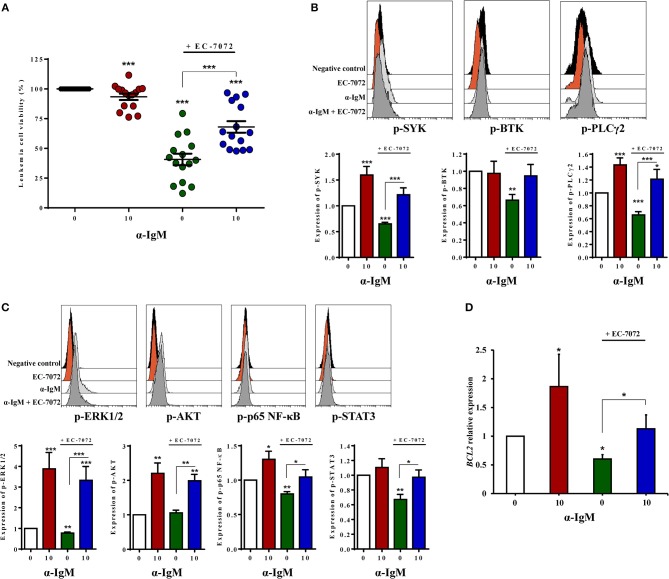
Activation of the BCR partially abrogates EC-7072-induced cell death of primary CLL cells. (A) Leukemia cell viability was determined by cytofluorometric assessment of DiOC6(3)/PI staining in PBMCs from patients with CLL (n = 15) incubated with EC-7072 (200 nM) in combination with α-IgM (10 μg/mL) for 24 h. The graph depicts the percentage of viable [DiOC6(3)+] cells normalized to their respective control (DMSO) condition for each individual patient and dark lines represent mean ± SEM. (B) Levels of phosphorylated SYK, BTK, and PLCγ2 were analyzed by phosphoflow in isolated leukemia cells from patients with CLL (n = 10) incubated with EC-7072 (200 nM) for 8 h followed by stimulation with α-IgM (10 μg/mL) for 15 min. Histograms depict the MFI from a representative patient and graphs show the MFI normalized to the control (DMSO) condition. (C) Levels of phosphorylated ERK1/2, AKT (n = 10), p65 NF-κB, and STAT3 (n = 6) were analyzed by phosphoflow in isolated leukemia cells from patients with CLL incubated with EC-7072 (200 nM) for 8 h followed by stimulation with α-IgM (10 μg/mL) for 15 min. Histograms depict the MFI from a representative patient and graphs show the MFI normalized to the control (DMSO) condition. (D) Isolated leukemia cells from patients with CLL (n = 4) were incubated with EC-7072 (200 nM) in combination with α-IgM (10 μg/mL) for 6 h and total RNA was extracted. Relative expression of BCL2 was analyzed by qPCR. Bars represent the mRNA relative expression normalized to the control (DMSO) condition. (Mean ± SEM) (*P < 0.05; **P < 0.01; ***P < 0.001; Student's t-test).